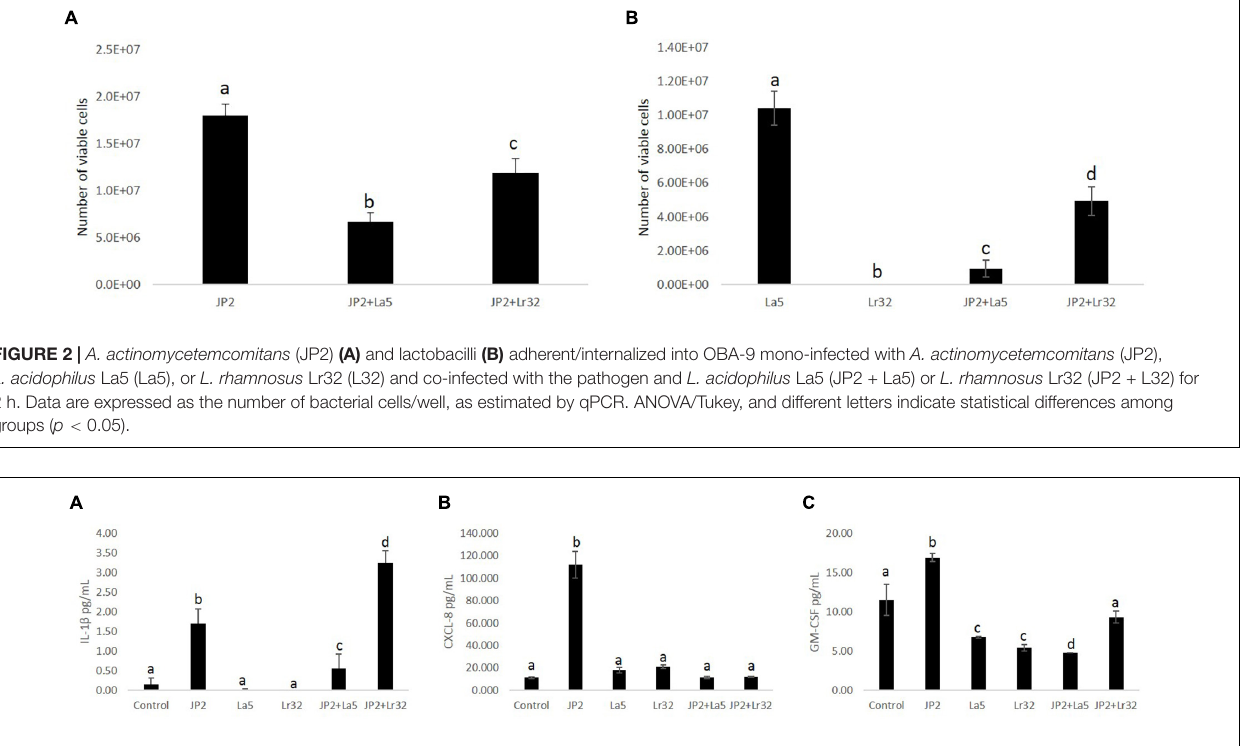
FIGURE 3 | Levels of IL-1 β (A) , CXCL-8 (B) , and GM-CSF (C) (pg/mL) determined by ELISA in cells supernatants of OBA-9 mono-infected with A. actinomycetemcomitans (JP2) and/or L. acidophilus La5 (La5) or L. rhamnosus Lr32 (L32) after 24 h of incubation. Control corresponds to non-infected GECs. ANOVA/Tukey; different letters indicate statistical differences among groups ( p <